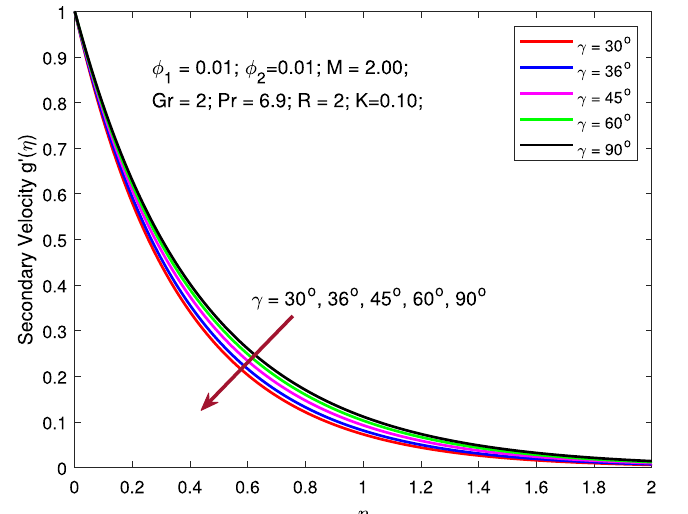
Figure 11. Variation of temperature with MF inclination